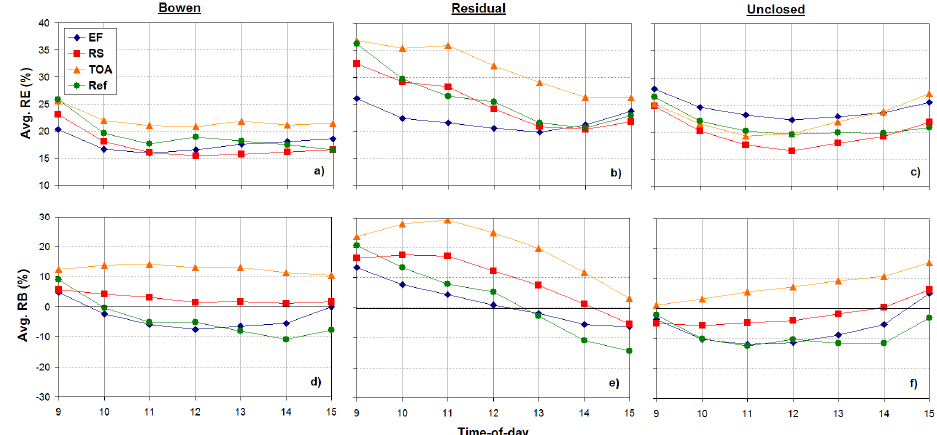
Figure 1. Statistical metrics computed using observed daytime-integrated “daily” ET (obtained using different closure constraints) and modeled values upscaled from half-hourly observations collected midday (from 0900 to 1500 solar time) time-of-day. Panels (a–c) show RE, averaged over all tower sites, for the Bowen, Residual and Unclosed data sets, respectively; panels (d–f) report the corresponding average RB values.